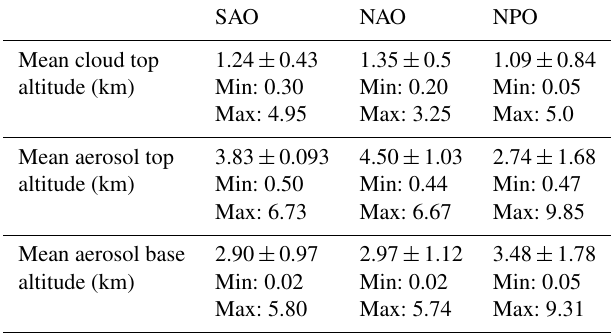
Table 3. Regional analysis using CALIOP measurements over 6 months (May to October 2008), over South Atlantic Ocean (SAO), North Atlantic Ocean (NAO) and North Pacific Ocean (NPO): mean cloud altitude for altitudes smaller than 5km, mean aerosol base and top altitudes for altitudes smaller than 10km.